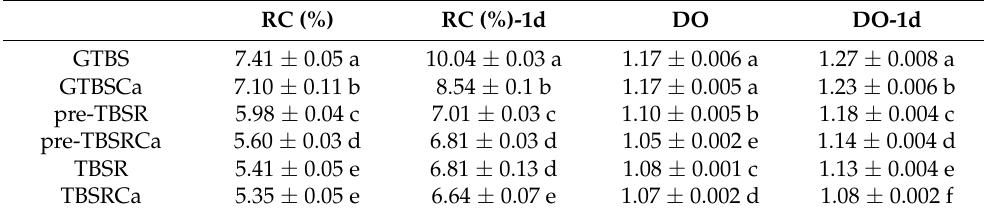
Table 1. Relative crystallinity (RC) and the ratio of 1047/1022 cm − 1 (DO) of